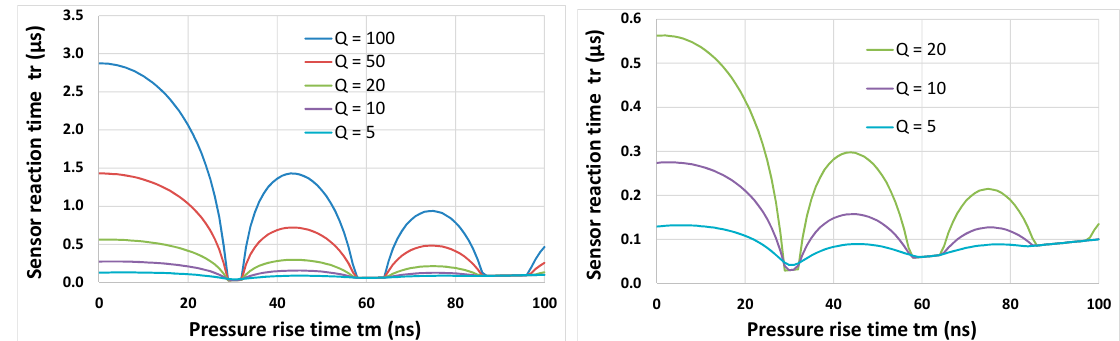
Figure 5. Sensor reaction time versus pressure rise time for different Q factor.